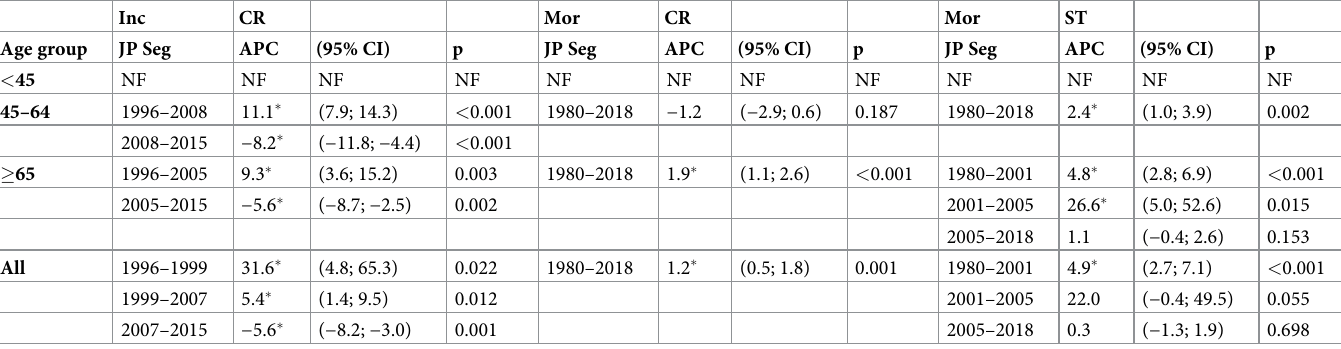
Table 3. Joinpoint analyses of prostate cancer incidence and mortality trends.